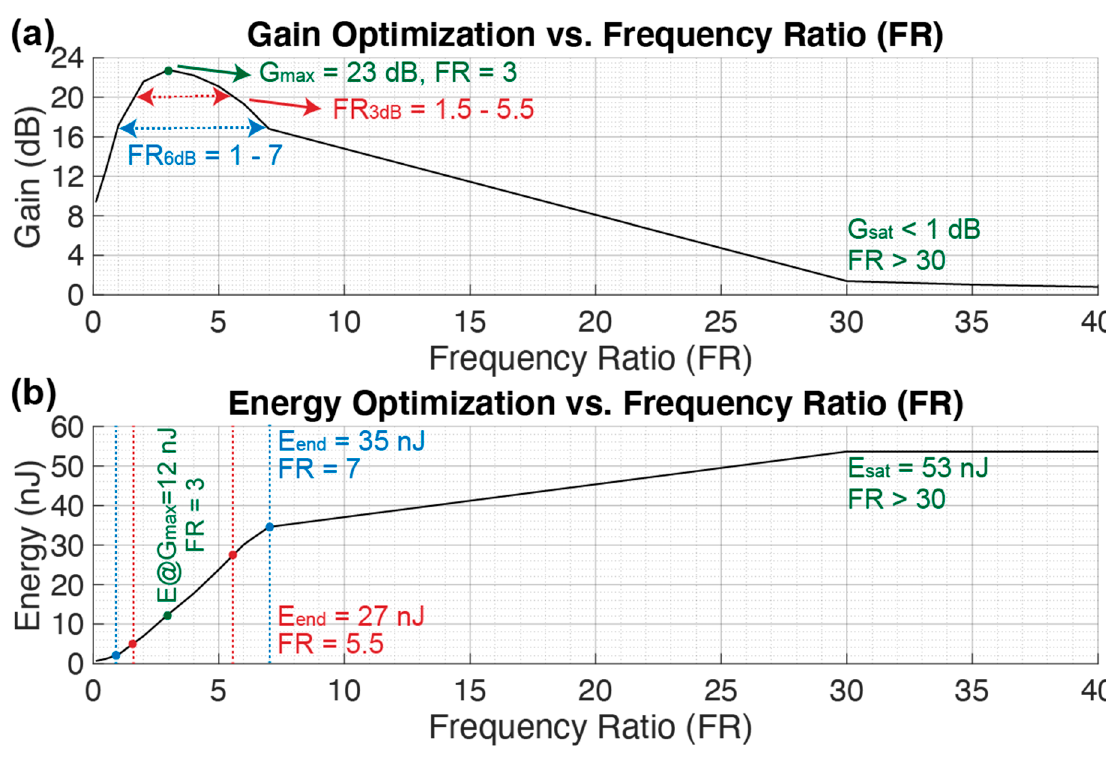
Figure 9. Gain ( a ) and energy ( b ) optimization over a sweep on the frequency ratio FR. The remaining values are maintained constant as in Table 1. Table 2. Summary of dMUT gains and energy optimization parameters and their values.